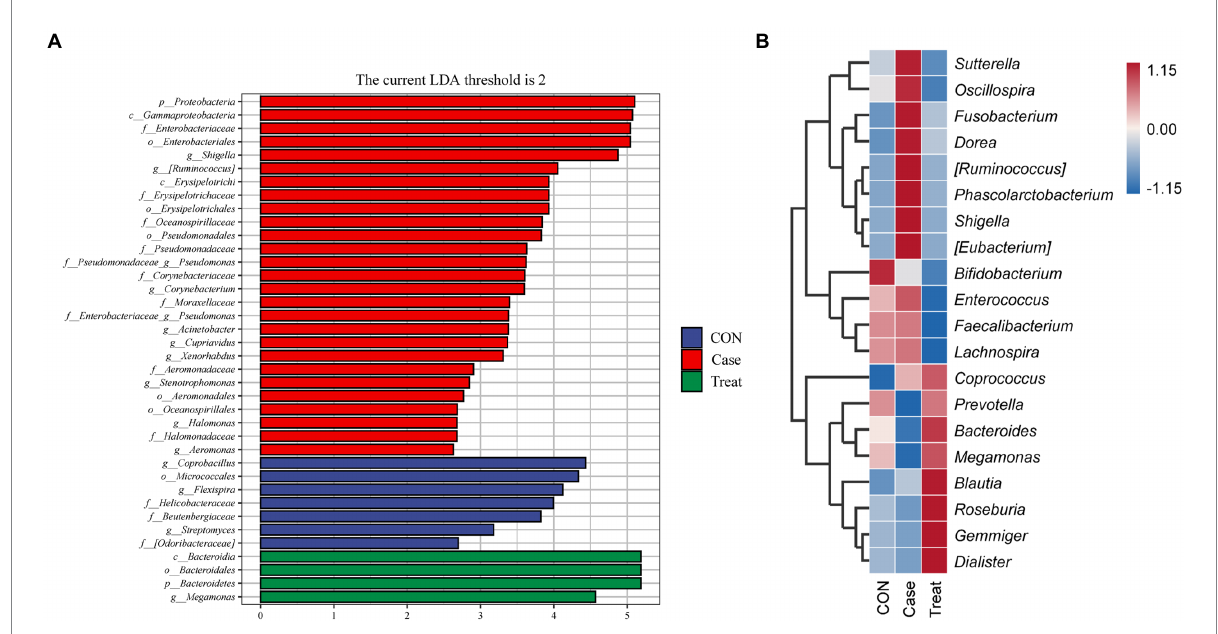
FIGURE 4 Species differences and marker species. (A) Lefse analysis. (B) Species composition heatmap at phylum level in Case group, Treatment group and CON